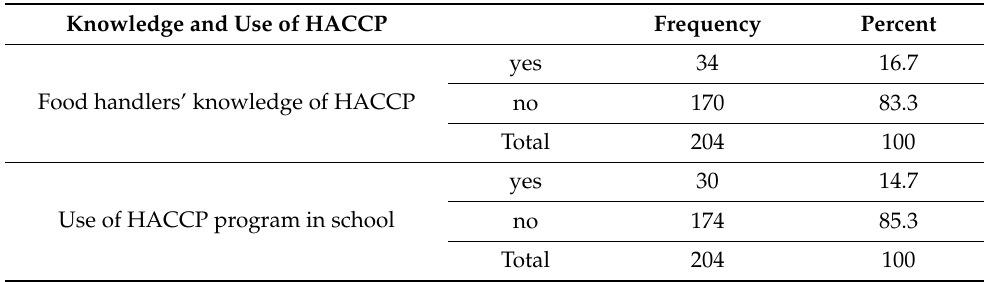
Table 4. Knowledge of Hazard Analysis and Critical Control Points (HACCP) by food handlers in Kenyan secondary school kitchens. Knowledge and Use of